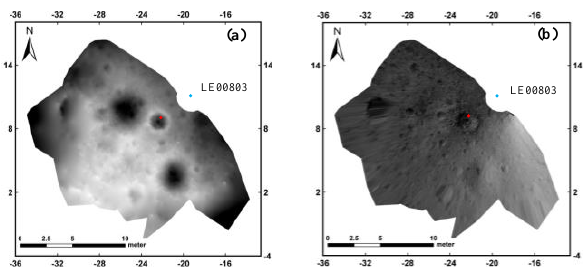
Figure 7. Automatically generated DEM (a) and DOM (b) from Navcam stereo images at waypoint